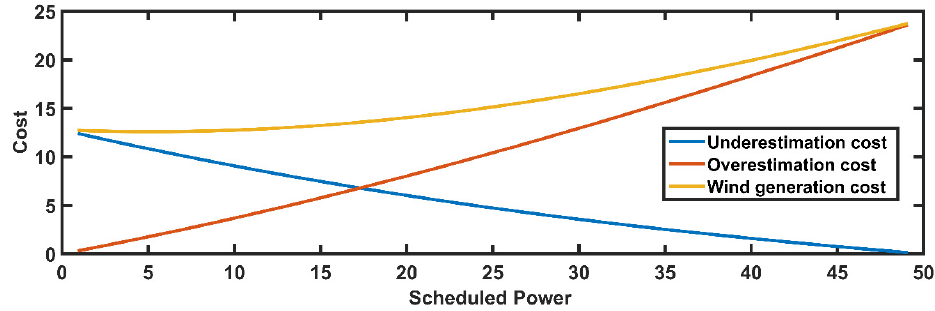
Figure 11. Wind generation cost versus scheduled power from 50 MW wind farm.